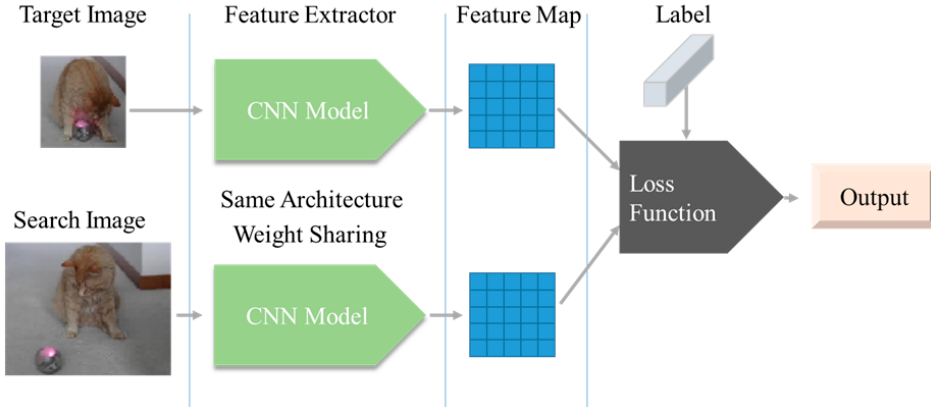
Figure 1. Standard Architecture of the Siamese Network.